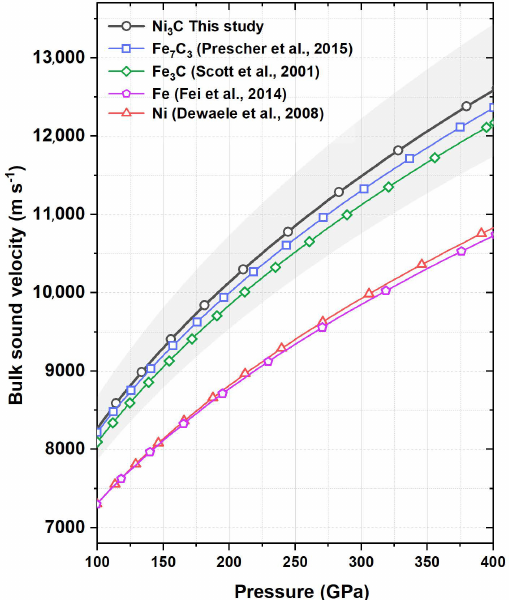
Figure 6. Calculated bulk sound velocity as a function of pressure for Ni 3 C (this study, black solid line with circles); Fe 3 C (green line with diamonds [33]) and Fe 7 C 3 (blue line with squares [2]); Ni (red line with triangles [21]); Fe (purple line with pentagons [35]) at 293 K.